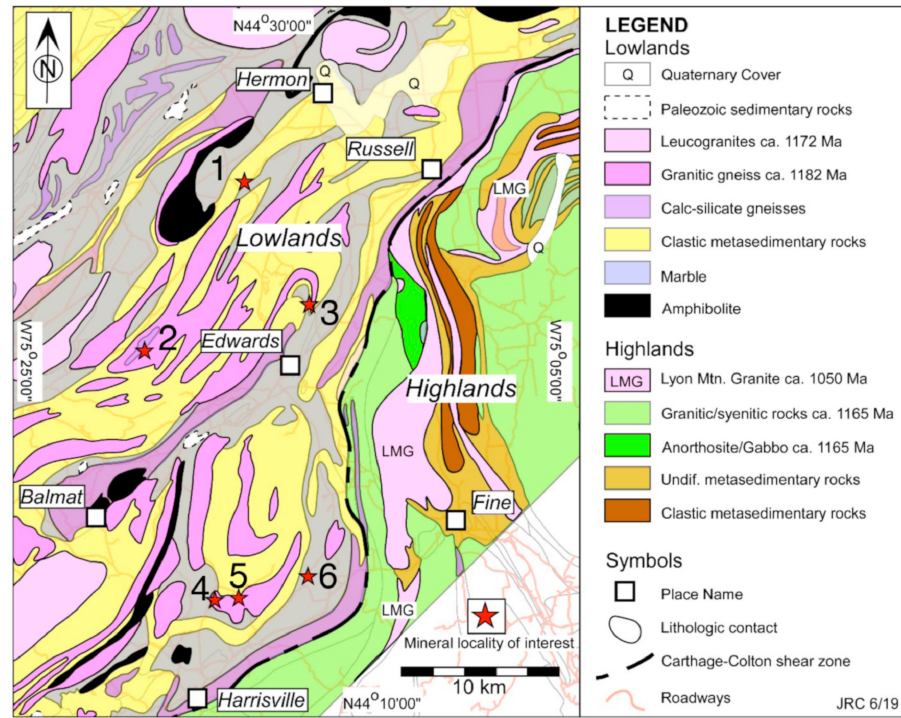
Figure 1. Grenville geology showing location of our six study sites. 1—Bowman prospect; 2—Chub Lake prospect; 3—Dodge mine; 4—Whitton prospect; 5—Toothaker Creek prospect; 6—Toothaker Pond prospect. Map courtesy of Je ff